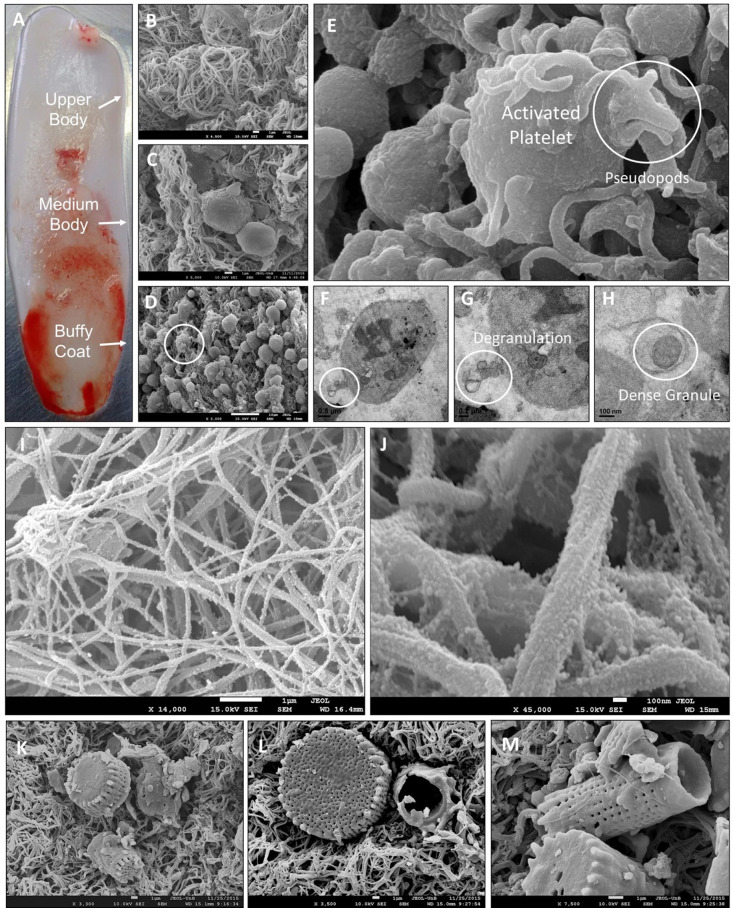
Photography showing in A the macroscopy of three regions of PRF (upper body, medium body and buffy coat) and eletrocmicrographs (B to M). Observe the ultrastructural arrangements of the three regions of PRF (B, C, D), activated platelet (E) with pseudopods and degranulation process (F, G, H). Also, observe the fibrin surface with polymeric chains and impregnated superficial nanoparticles (I, J). In K, L, M are shown interspersed plankton diatoms frustules in PRF matrix obtained by Vacuette™ plastic tube with a clot activator.